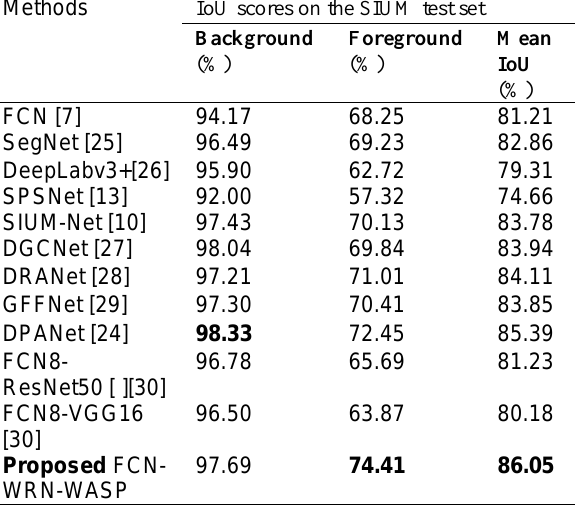
Figure 5. Representative fish segmentation results by the proposed approach on the SIUM data. The Ground truths and Predictions are overlaid on the gray scale image for better visualization. Table 2. Comparison between other methods for fish segmentation on the Sium data